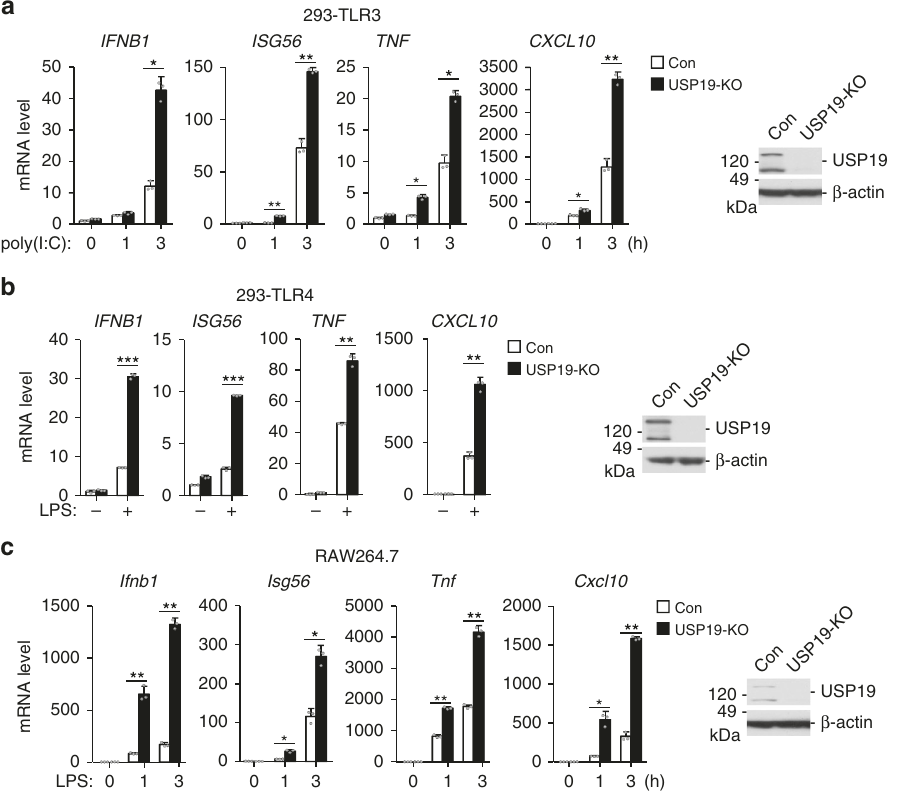
Fig. 1 USP19 negatively regulates TLR3/4-mediated signaling. a Effects of USP19-de fi ciency on transcription of downstream genes induced by poly(I:C). USP19-de fi cient (USP19-KO) 293-TLR3 cells were generated by the CRISPR-Cas9 method. USP19-KO and control cells were treated with poly(I:C) (50 μ g/ml) or left untreated for the indicated times. The mRNA levels of the indicated genes in the cells were measured by qPCR experiments. USP19 levels in the cells were analyzed by immunoblots (right blots). b , c Effects of USP19-de fi ciency on transcription of downstream genes induced by LPS. USP19-de fi cient (USP19-KO) 293-TLR4 or RAW264.7 cells were generated by the CRISPR-Cas9 method. The indicated USP19-KO and control cells were treated with LPS (100 ng/ml) or left untreated for 3 h. The mRNA levels of the indicated genes in the cells were measured by qPCR experiments. USP19 levels in the cells were analyzed by immunoblots (right blots). Graphs show mean ± SD; n = 3 independent samples. * P < 0.05, ** P < 0.01, *** P < 0.001 (unpaired t- test). Data are representative of three experiments with similar results. Source data are provided as a Source Data fi le. Error bars represent standard deviation of the fi cient to D -galactosamine or LPS. Since poly(I:C) alone is insuf cause in fl ammatory death of mice, D -galactosamine is an agent